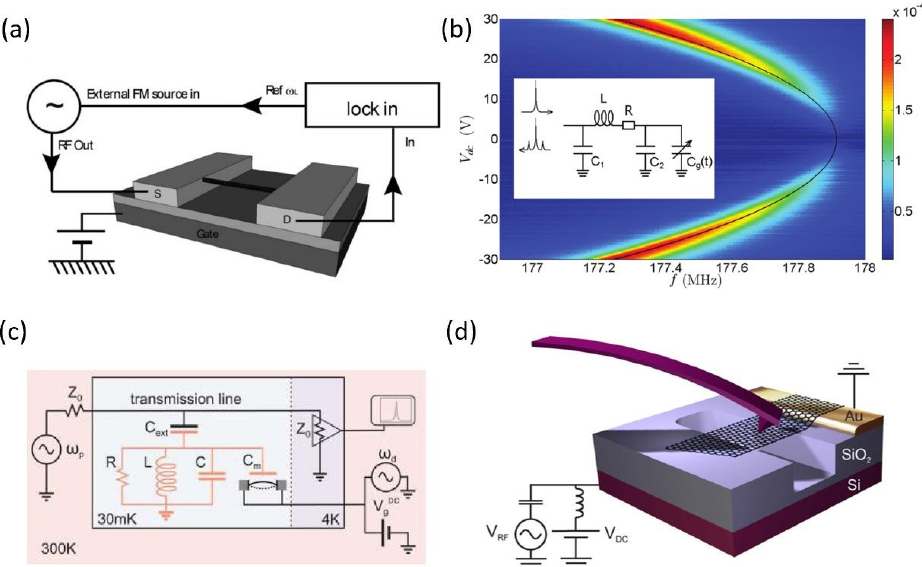
Figure 4. Detection schemes for graphene resonators. ( a ) Mixing technique with a frequency modulation (FM) signal [42]. ( b ) The RF cavity readout scheme with coupling of the graphene resonator to an LC circuit [45]. ( c ) Detection scheme with coupling of a graphene resonator to a superconducting microwave cavity [23]. ( d ) Imaging the vibration eigenmodes of graphene with SFM [48].